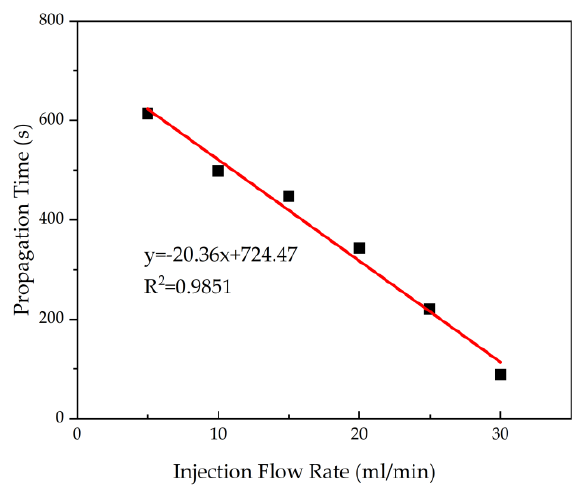
Figure 10. Influence of injection flow rate on the propagation time.